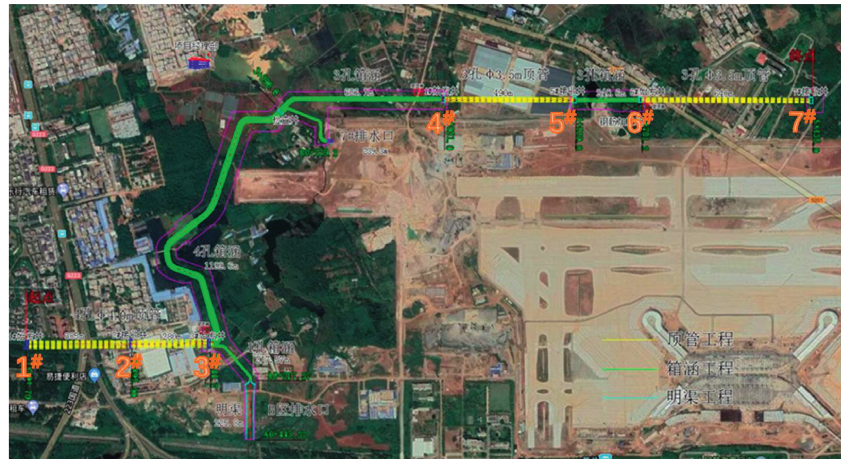
Figure 5: Aerial view of the project.